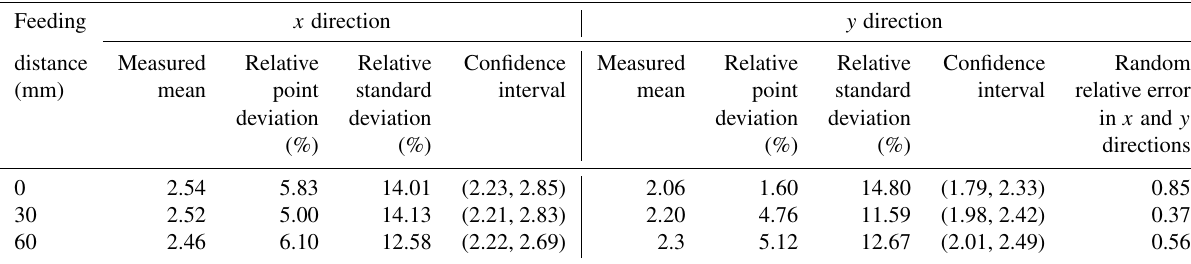
Table 5. The error analysis result of the pitch angle’s remote center point. Feeding x direction z direction distance Measured Relative Relative Confidence Measured Relative Relative Confidence Random (mm) mean point standard interval mean point standard interval relative error deviation deviation deviation deviation in x and z (%) (%) (%) (%)